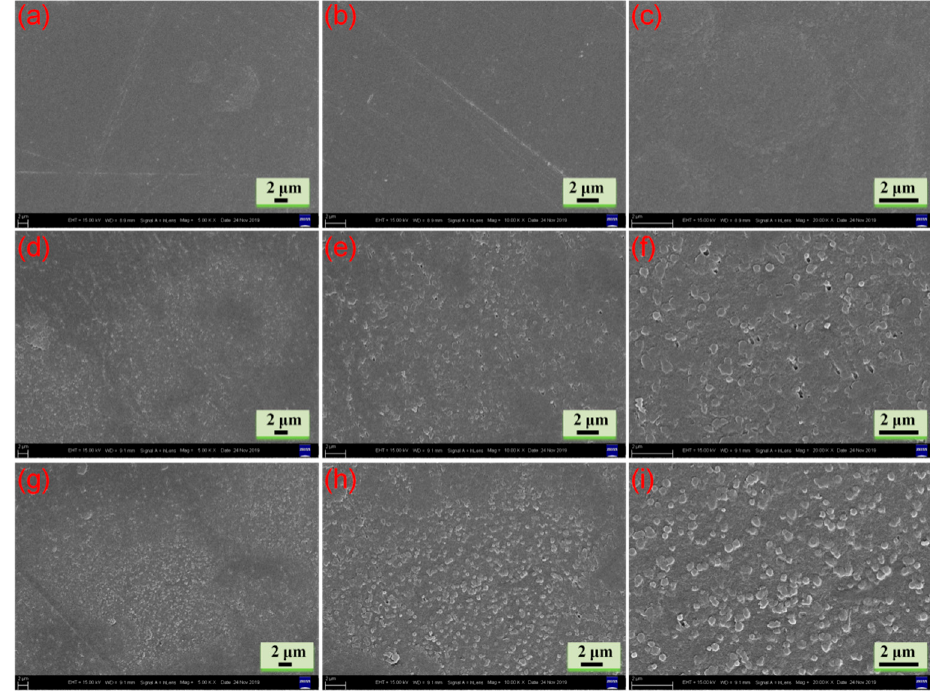
Figure 3. Surface SEM images of CBP ( a – c ), PCBP-1 ( d – f ), and PCBP-2 ( g – i